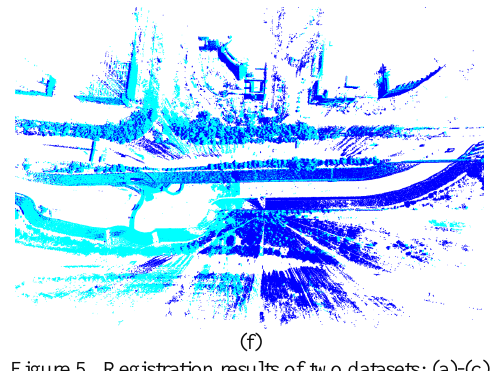
Figure 5. Registration results of two datasets: (a)-(c) registration of adjacent mountainous stations, (d)-(f) registration of adjacent riverbank stations.